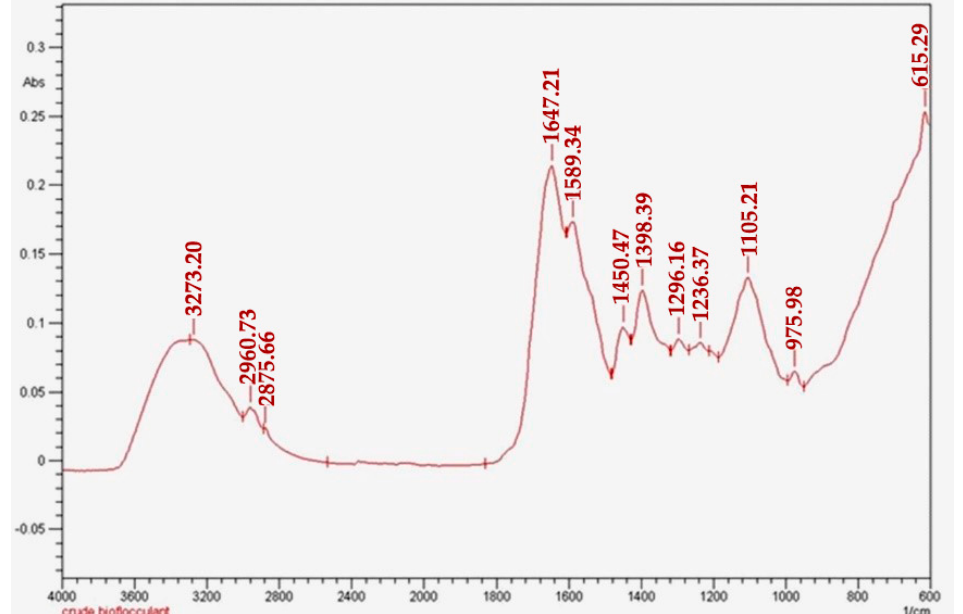
Figure 6. FT-IR spectrum of crude bioflocculant from Bacillus nitratireducens.